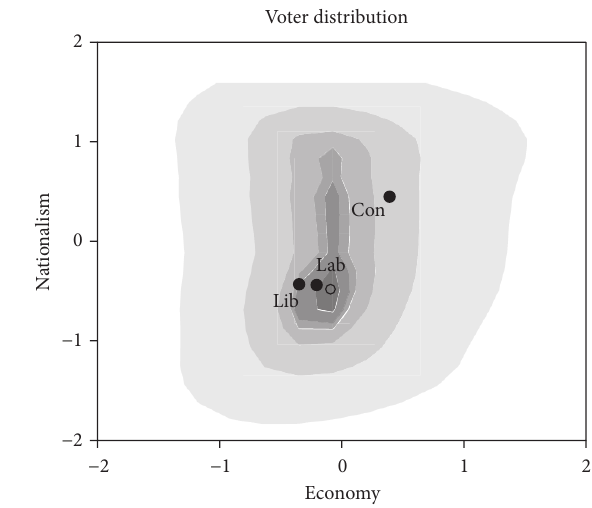
Figure 5: Voter and party positions in Britain in